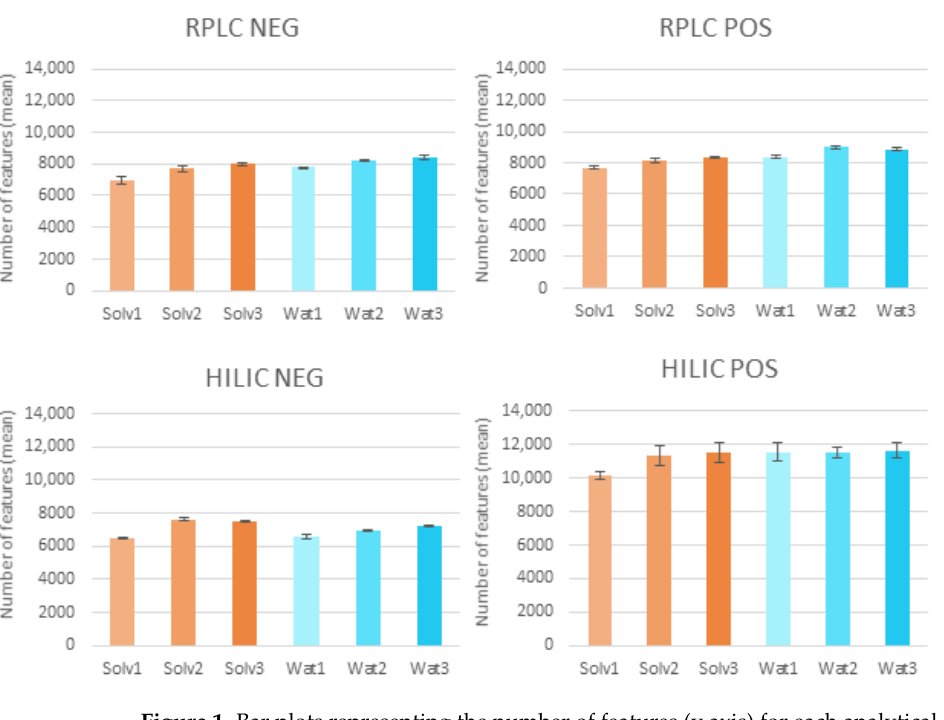
Figure 1. Bar plots representing the number of features (y axis) for each analytical condition (reverse- phase liquid chromatography, RPLC, and hydrophilic-interaction liquid chromatography, HILIC) with negative (NEG) and positive (POS) ionisation mode (x axis), and within a plot, different